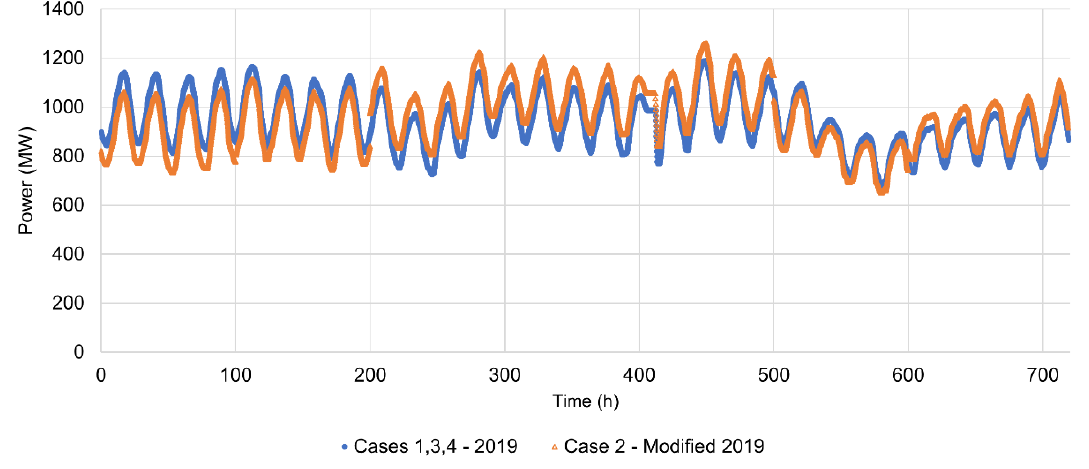
Figure 8. 2019 and 2050 variable renewable energy penetrations (solar/wind). A technology-invariant curtailment penalty of 110 US$/MWh based on available literature [31] was considered in all case studies. The main purpose of this penalty is to maintain the curtailment at minimum levels, i.e., the wind/solar supply is only curtailed when the lack of curtailment renders the dispatch infeasible. The battery lifecycle is assumed to be relatively shorter than the lifetime of the power plants, as it depends on the degradation and the number of cycles. In this study, a penalty term is considered in the objective to take into account each cycle completed by the NaS batteries with a cost of 300 US$/kWh and a maximum number of 2500 cycles. A complete charge/discharge of the battery is considered as a cycle. Figures 9 – 13 show the results as stacked plots for the four case studies, i.e., the plot is shown as cumulative in the order of appearance of each technology (SCPC, NGCC, NGCC 2, NaS batteries, and renewables). For instance, if at some time instance a second line superimposes the first line, the energy system of the second line is not providing energy at that instance. The amount of energy being provided by a specific energy system is the subtraction between the previous and current energy system. This type of plot is chosen to rapidly verify if the power of the grid is balanced. If the line that represents the last energy source to be added matches the contour of the gray shaded area (demand), that means the power is balanced.